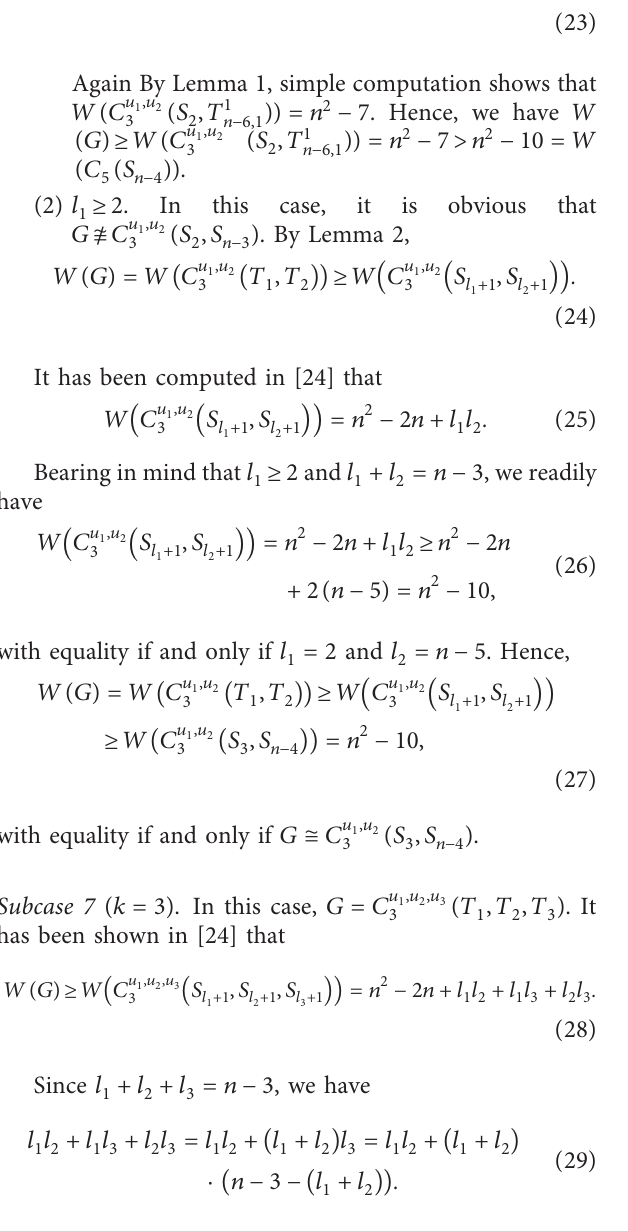
( T 1 ) (a) and C n − 5 , 1 3